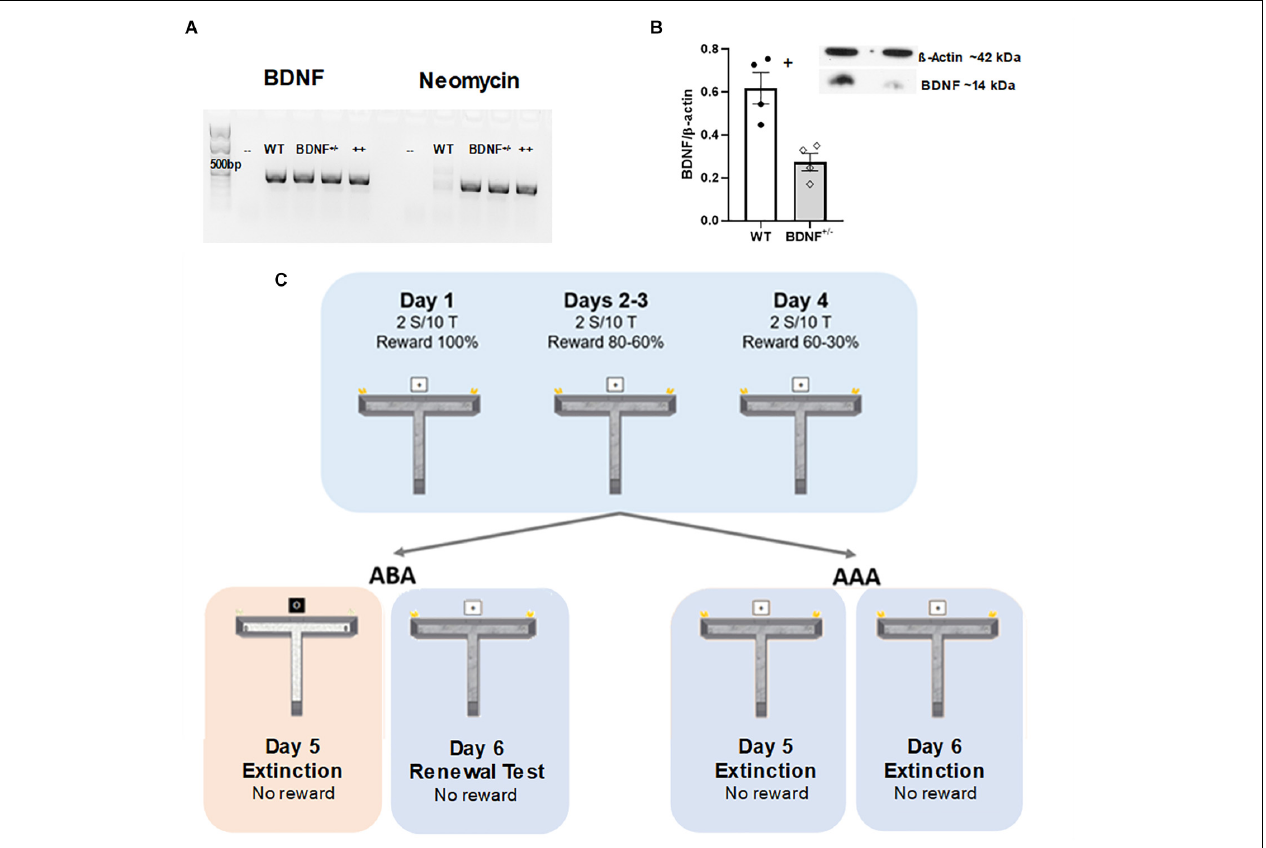
FIGURE 1 | Genotyping, Western blots and schema of the behavioral protocol. (A) Genotyping of BDNF mice. In BDNF + / − animals, a neomycin-resistant gene, surrounded by a glycerate kinase gene promotor and a polyadenylation signal, replaces one allele of the BDNF protein-coding exon. Most of the mature BDNF is therefore depleted, and the introduced gene serves as a biomarker. BDNF + / − animals (bands 3 and 4, from the left in each gel) expressed both the neomycin-resistant gene (500 bp) as well as BDNF (500 bp), whereas in the wild type (WT, second band from the left) animals only the BDNF bands are observable. – and ++ bands correspond to negative and positive controls, respectively, for both genes. (B) Hippocampal BDNF expression is depleted in the BDNF + / − animals. The expression of BDNF (14 kDa) and β -actin (42 kDa) protein in the hippocampus of both BDNF + / − ( n = 4) and wild type littermates (WT) animals ( n = 4) was evaluated by Western blot. β -Actin was used as a protein loading control, and each individual value was normalized by the β -Actin expression level. Expression of mature BDNF was significantly lower in the transgenic animals as compared to their WT littermates. Group averages ( ± S.E.M) are indicated by vertical bars, points represent individual measurements ( p = 0.006). (C) Schema of the behavioral protocol. Top: On Day 1, animals participate in two sessions each comprising ten consecutive trials each (separated by 10-min intervals) that include a reward probability of 100%. On Day 2 two ten trial sessions at 80% of reward probability occur. On Day 3, the reward probability of the first session is 80%, and of the second session is 60%. On Day 4, the reward probability declines from 60% in the first session, to 30% in the second session. Bottom right: On Days 5 and 6, animals participate in the extinction learning protocol in the same context (AAA) in the absence of a reward. Bottom left: In the ABA paradigm animals engage in extinction learning in the presence of a context change on Day 5. During extinction learning, the context (floor pattern, distal cues, odor cues) are changed. On Day 6, renewal is tested by re-exposure to context A. No reward is present in the maze during the extinction or renewal test